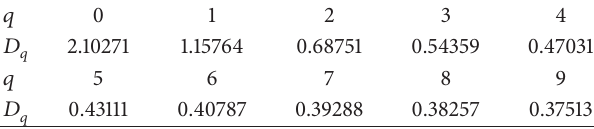
Table 7: The generalized dimension value of fault-free signal.